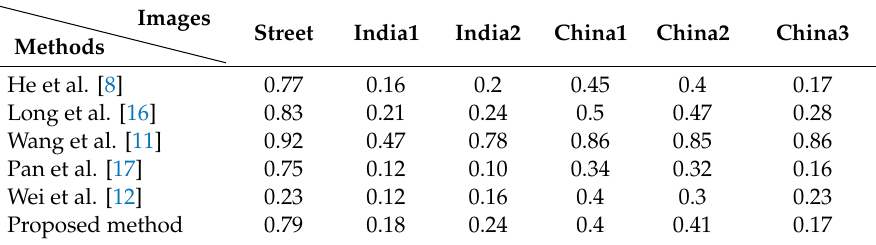
Table 3. Comparison results of e using various methods.